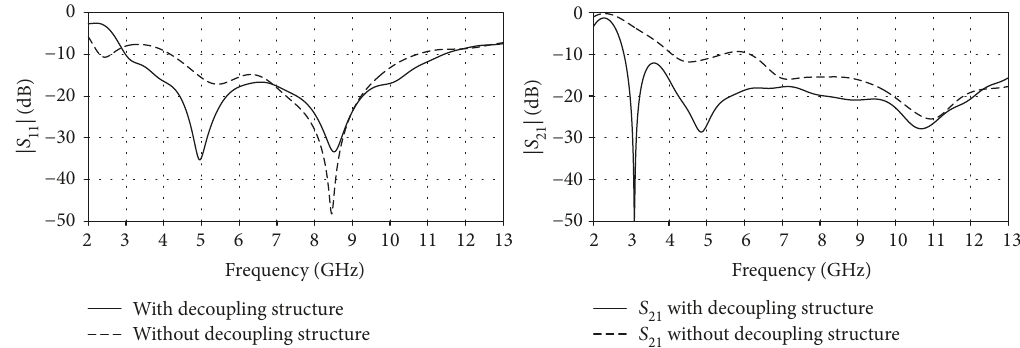
Figure 6: Simulated S -parameters.